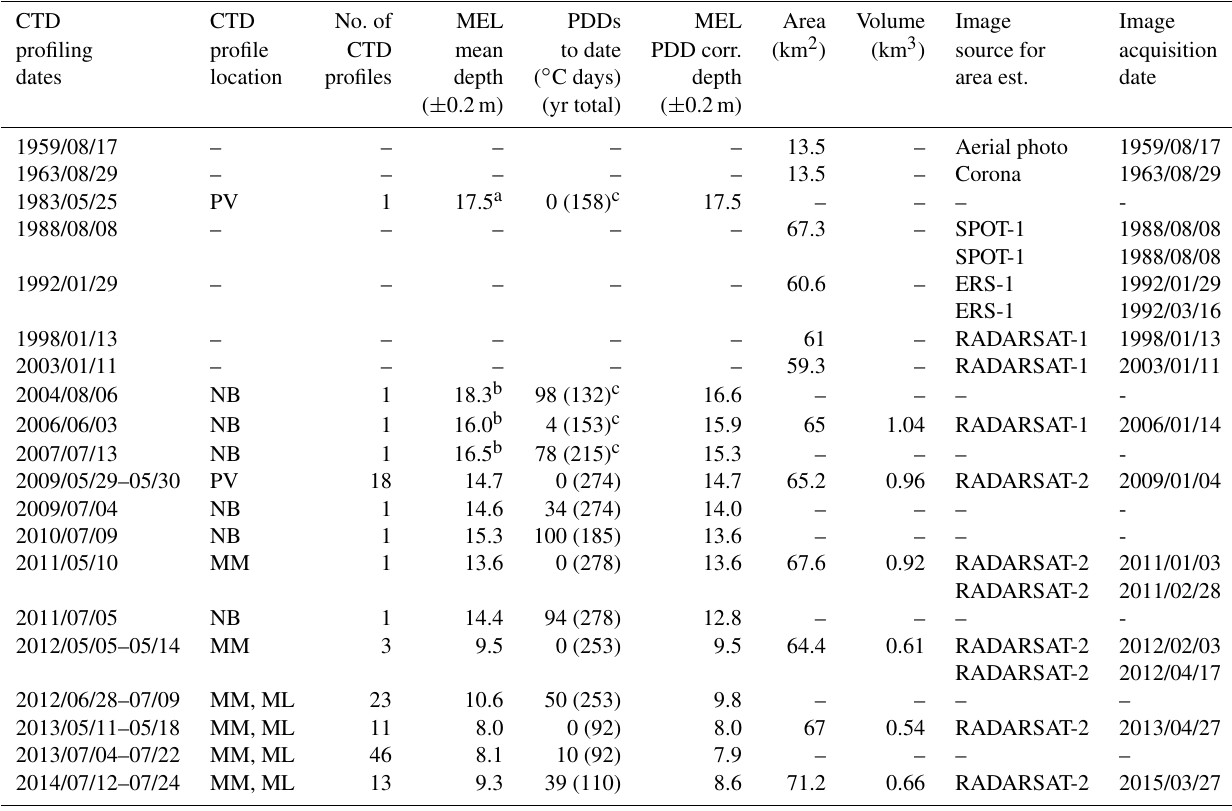
Table 1. Milne Fiord epishelf lake depth, area, volume, and related observations. CTD CTD No.